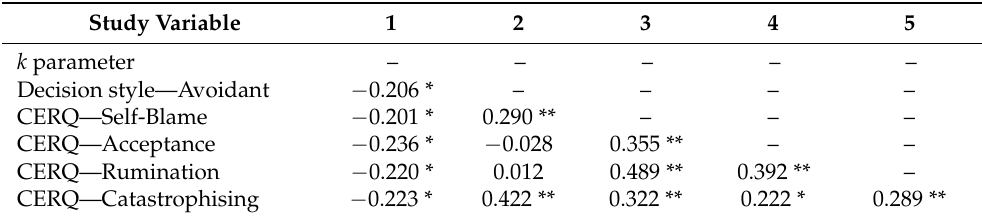
Table 3. Significant correlations between the cognitive and affective individual predictors and delay discounting scores ( k parameter) in the domain of